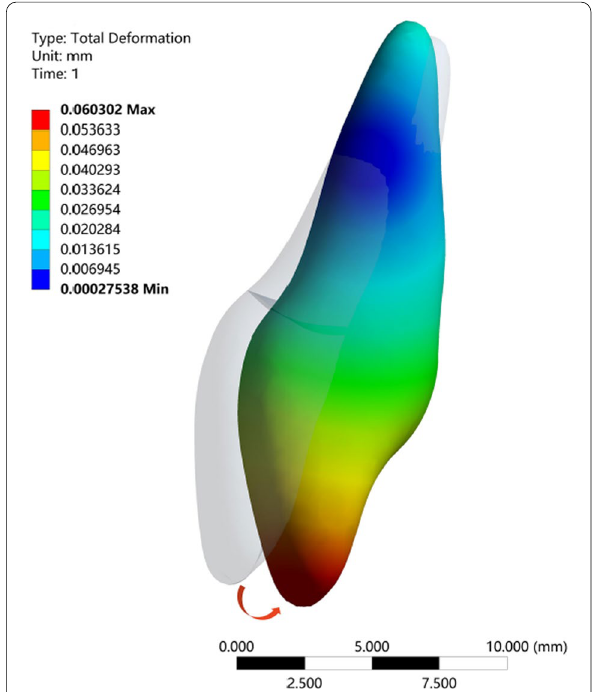
Fig. 4 The clockwise moment and palatal inclination magnified by 50-fold for a tooth without a power ridge